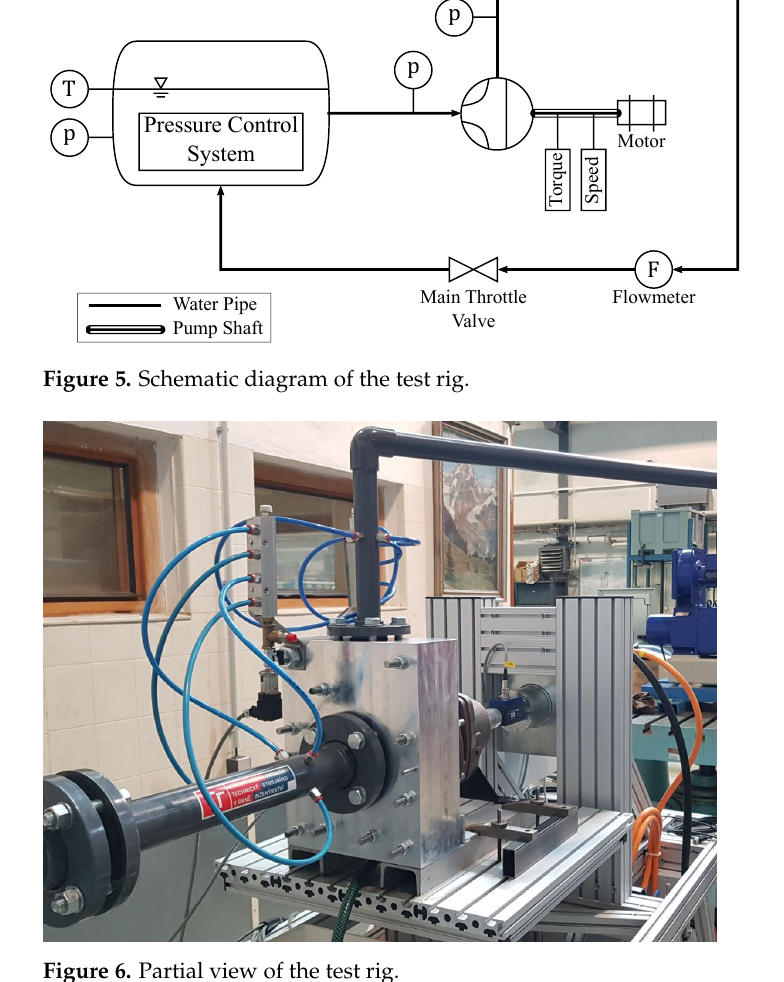
Figure 6. Partial view of the test rig.